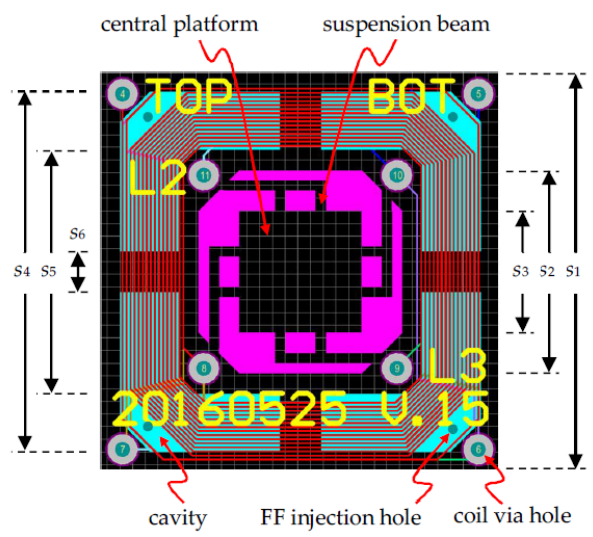
Figure 2. PCB layout of proposed harvester. FF: Ferrofluid. Table 1. Design parameters of proposed electromagnetic (EM) harvester. Some parameters are defined in Figure 2.